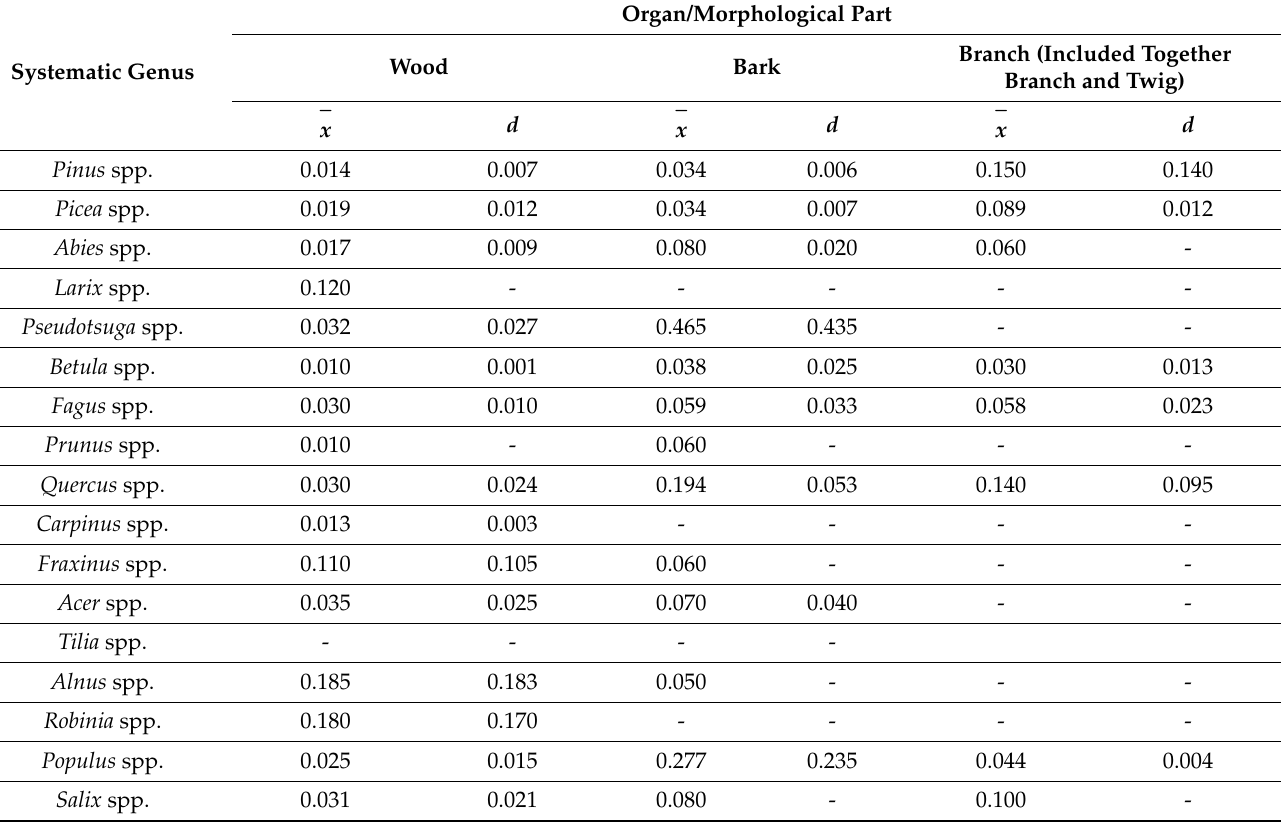
Table A20. Average value and average deviation of the sulphur content (% d.m.) in various organs of particular systematic genera trees.